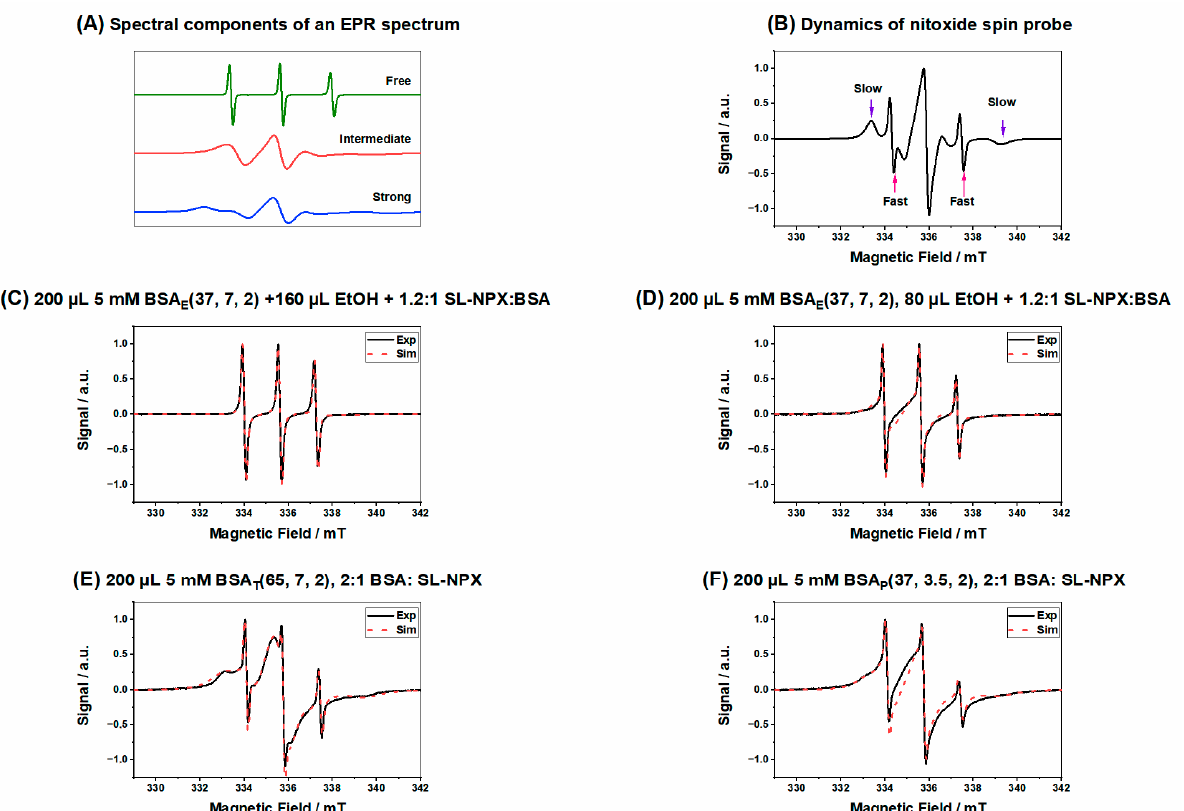
Figure 5. ( A ) Individual components of nitroxide radicals in EPR spectra, as derived from spectral simulation of different rotational motion, ( B ) features of the different components of an EPR spectrum for nitroxide spin probe, ( C ) SL-NPX-loaded BSA E (37, 7, 2) at a 1.2:1 SL-NPX:BSA molar ratio with 160 µ L ethanol, ( D ) SL-NPX-loaded BSA E (37, 7, 2) at a 1.2:1 SL-NPX:BSA molar ratio with 80 µ L ethanol, ( E ) SL-NPX-loaded BSA T (65, 7, 2) at a 2:1 SL-NPX:BSA molar ratio, and ( F ) SL-NPX-loaded BSA P (37, 3.5, 2) at a 2:1 SL-NPX:BSA molar ratio.